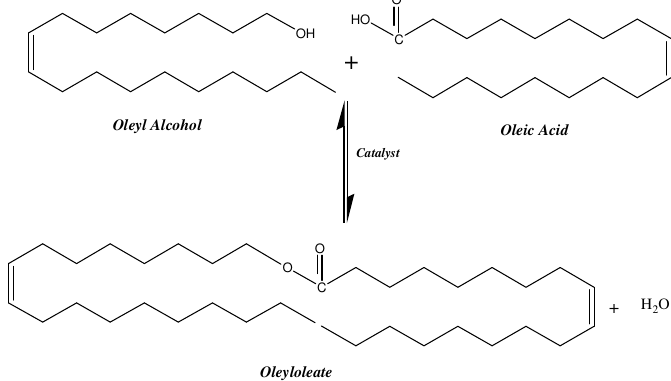
Figure 1. Synthesis of